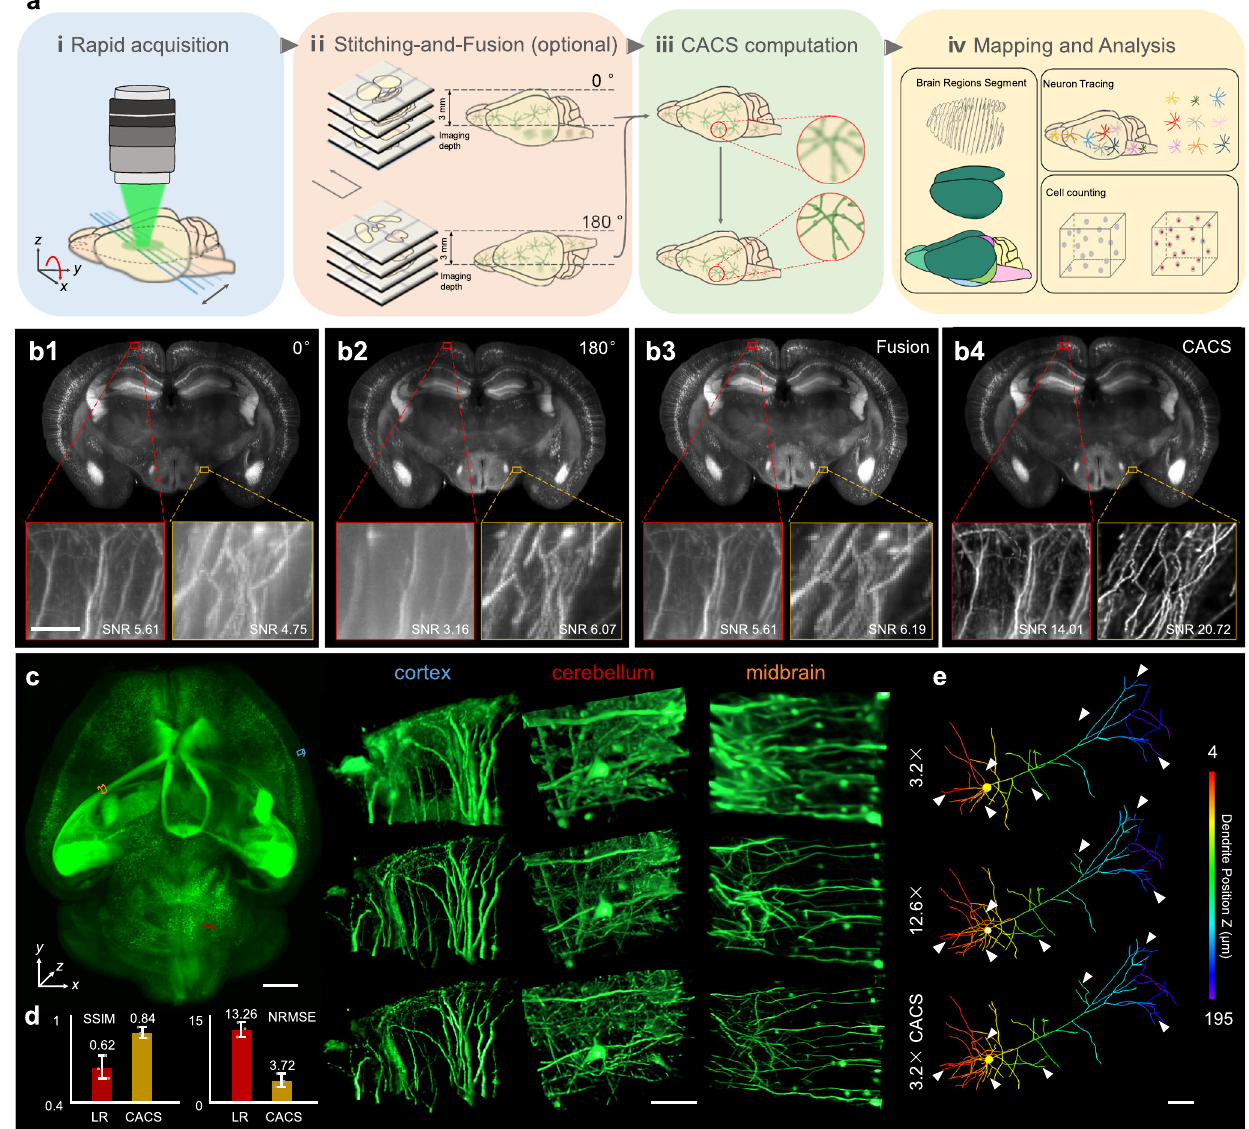
Fig. 3 Whole-brain mapping pipeline. a Flow chart of whole-brain data acquisition and processing, which includes: (i) rapid image acquisition by ×3.2 Bessel sheet, with total 12 tiles under 2 views acquired in ~10 min. (ii) tile stitching for each view followed by 2-view weighted fusion, to reconstruct a scattering-reduced whole brain at low resolution (2- μ m voxel). The full implementation of this step would be not necessary if the sample is optimally cleared or imaged under lower magni fi cation. (iii) CACS computation to recover a digital whole brain with improved resolution (0.5- μ m iso-voxel size) and SNR. (iv) quantitative analyses, such as brain region segmentation, neuron tracing, and cell counting, based on high-quality whole-brain reconstruction. b MIPs of reconstructed coronal plane ( x-z , 150- μ m thickness) in whole brain by 0°, 180° single view Bessel sheet, 2-view fusion and CACS computation. The magni fi ed views of two small regions selected from z = 100 and z = 4500 μ m depth further show the effect of 2-view fusion and CACS. Scale bar, 50 μ m. c 3D visualization of a whole digital mouse brain (left, ~400mm 3 , 3-trillion voxels) reconstructed from the ×3.2 Bessel-CACS results, whose raw data were rapidly acquired in ~10 min. Three magni fi ed volumes from the cortex (blue), cerebellum (red) and midbrain (orange) regions by raw ×3.2 Bessel sheet (top row), ×3.2 Bessel-CACS (middle row), and ×12.6 Bessel sheet (bottom row) modes are compared to show the super-resolution capability of CACS procedure. Scale bars, 1 mm for whole-brain visualization, 50 μ m for ROIs. d SSIM and NRMSE values of 12 brain subregions (100 × 100 × 100 μ m 3 ) images by raw Bessel sheet and Bessel-CACS. The quantitative analyses verify a high recovery fi delity of CACS results as compared to the high-resolution ground truths. Data are presented as mean values ± SD. e Tracing of a single pyramidal neuron under three modes. The same neuron imaged by three modes was segmented and traced using Imaris. It ’ s shown that CACS result enables the identi fi cation of more abundant neuron substructures. Scale bar, 50 μ m. Source Data are available as a Source Data